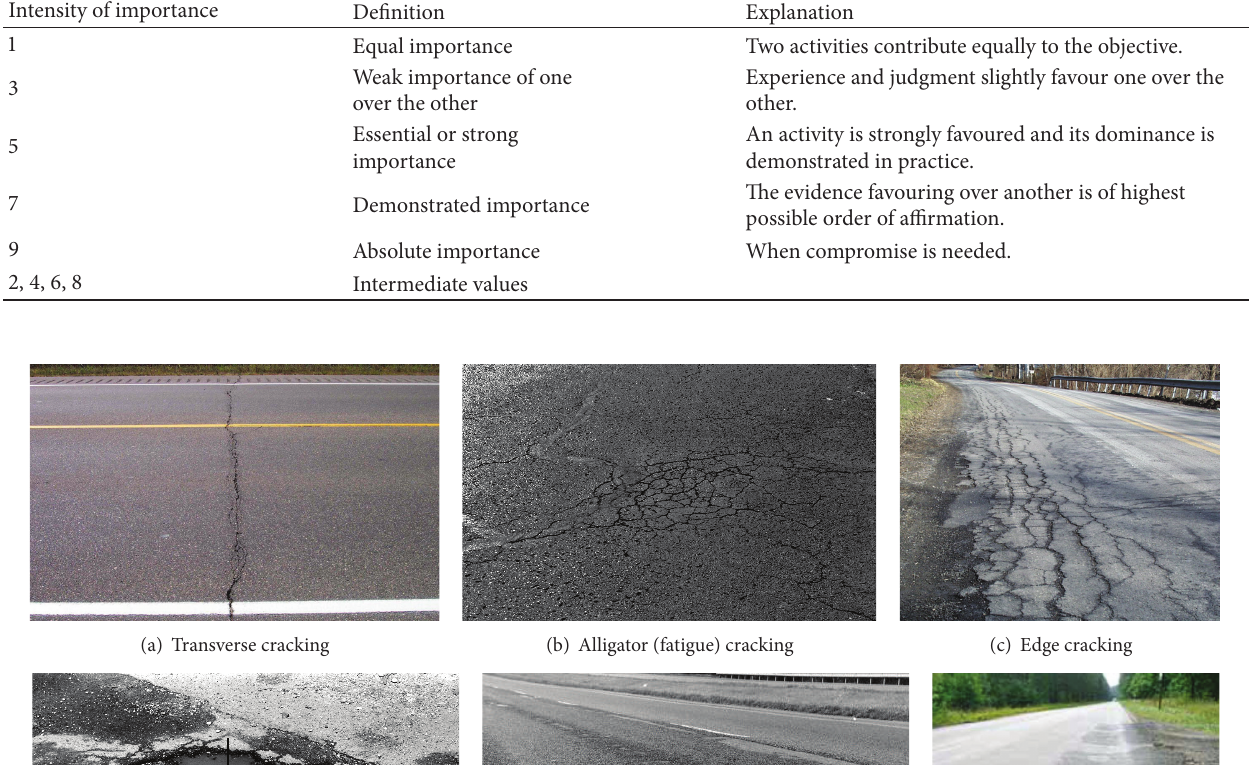
Table 2: The nine-point Saaty scale of relative importance [4].